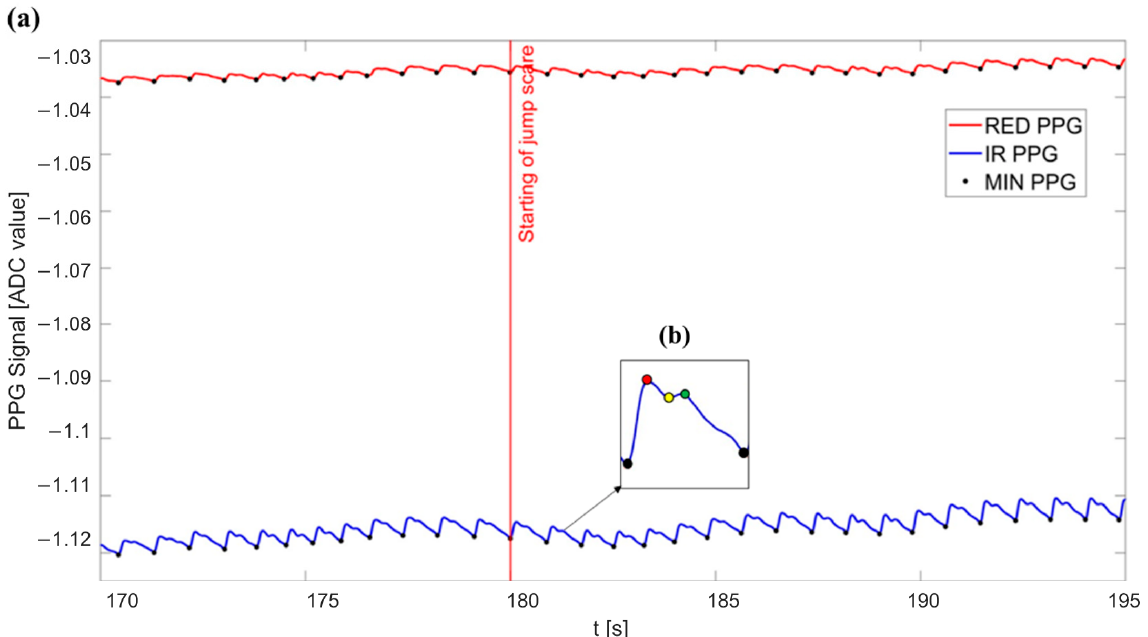
Figure 4. ( a ) 25-s excerpt of the PPG signals acquired on a subject during the experimental protocol. Signals are represented as raw ADC values. Please also note that for visualization purposes the signals were inverted during post-processing to reflect a typical PPG waveform. The red- and blue- colored curves indicate the PPG signals acquired using red and infrared light, respectively. Black dots represent the minimum value of each PPG waveform, detected for each cardiac cycle to measure the PPI intervals. The vertical red line denotes the transition between the R1 and SF phase. ( b ) The inset shows a zoom of an exemplary PPG waveform acquired with our device. In the inset: systolic foot (black dots), systolic peak (red dot), diastolic notch (yellow dot), and diastolic peak (green dot).